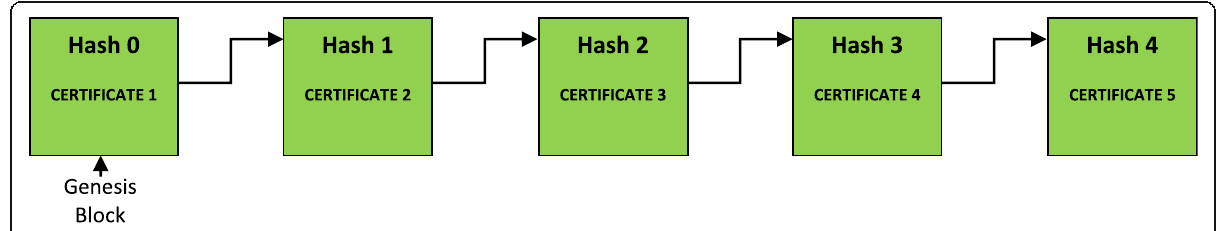
Fig. 5 Untampered blocks in other Distributed network of nodes